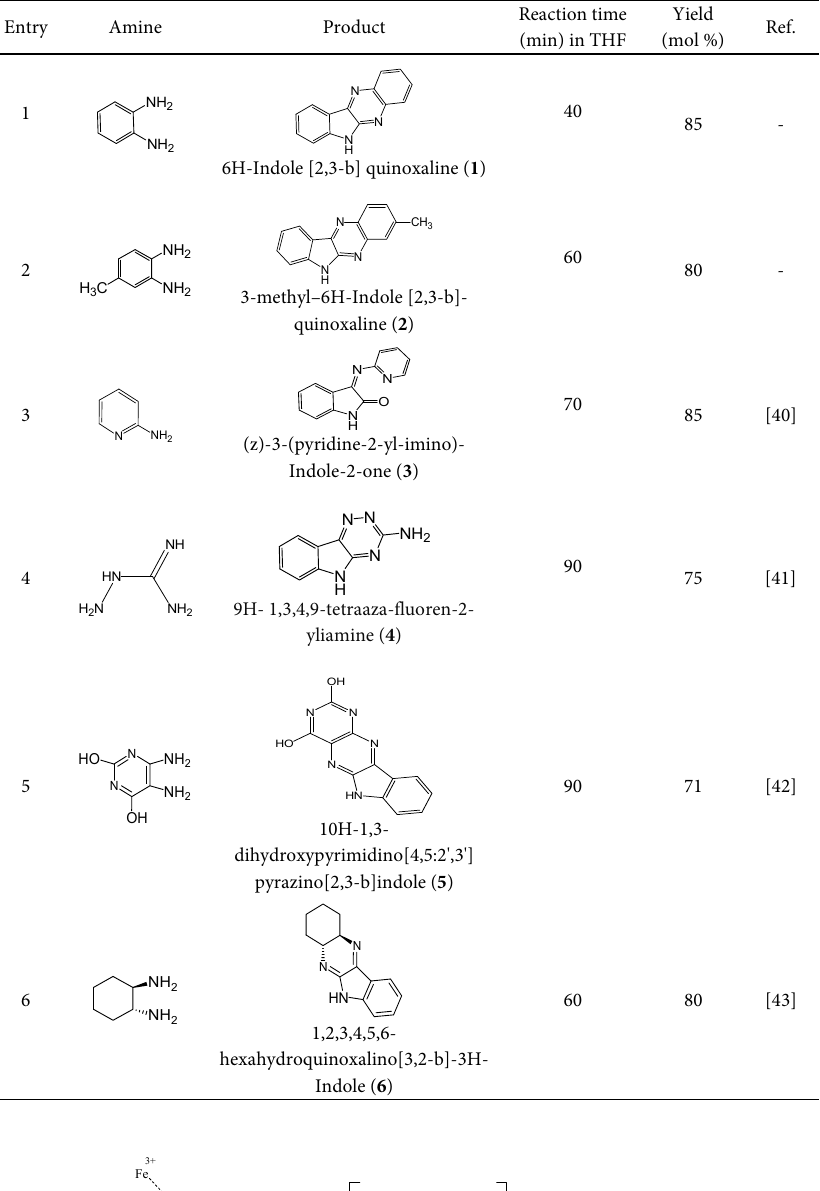
Table 2: Synthesis of indole derivatives using Fe